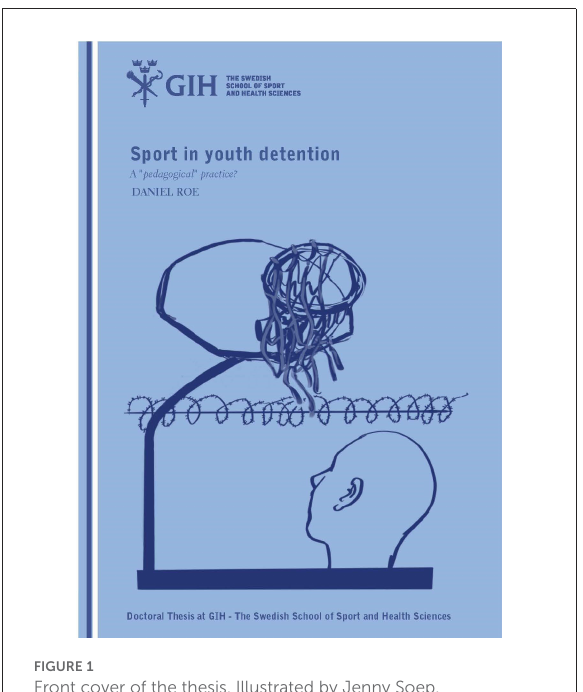
FIGURE1 Front cover of the thesis. Illustrated by Jenny